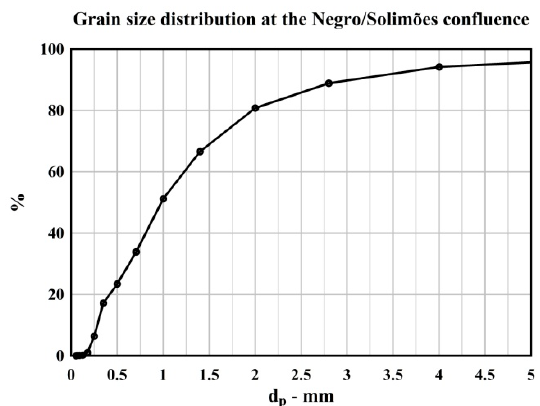
Figure 7. Grain size distribution [48].